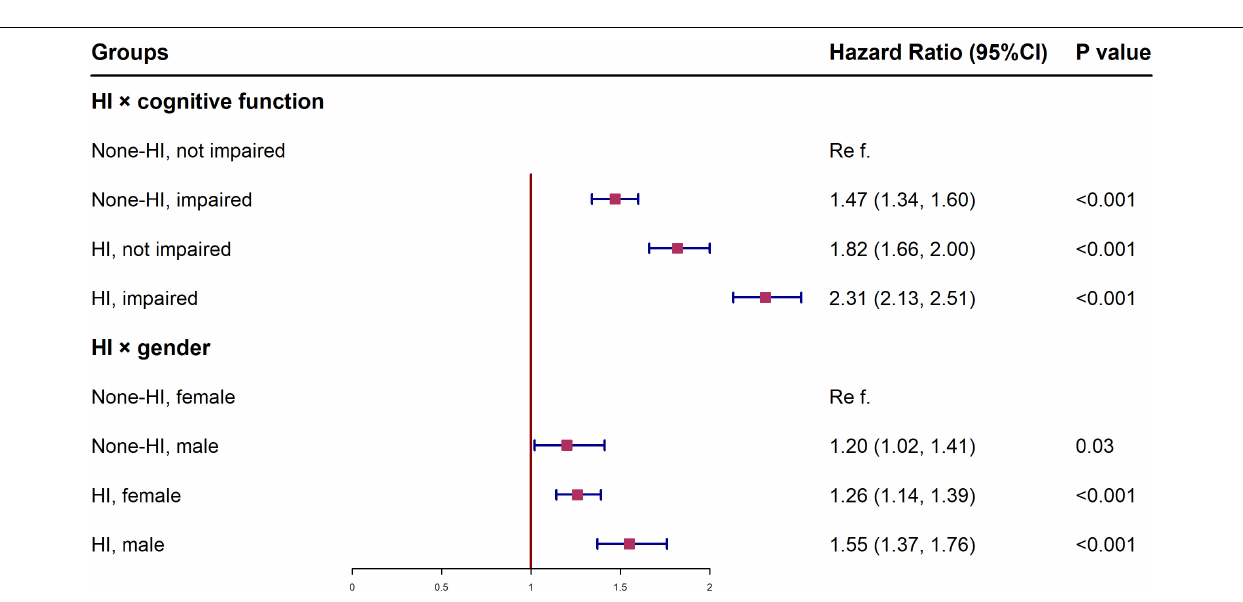
FIGURE 2 | Multivariable-adjusted hazard ratios and 95% confidence intervals of all-cause mortality for different subgroups. † All models were adjusted for gender, age education, residence, and marital status, smoking status, drinking status, regular leisure activities, ADL, hypertension and diabetes. HI, hearing impairment; HR, hazard ratio; CI, confidence interval; ADL, activities of daily living.